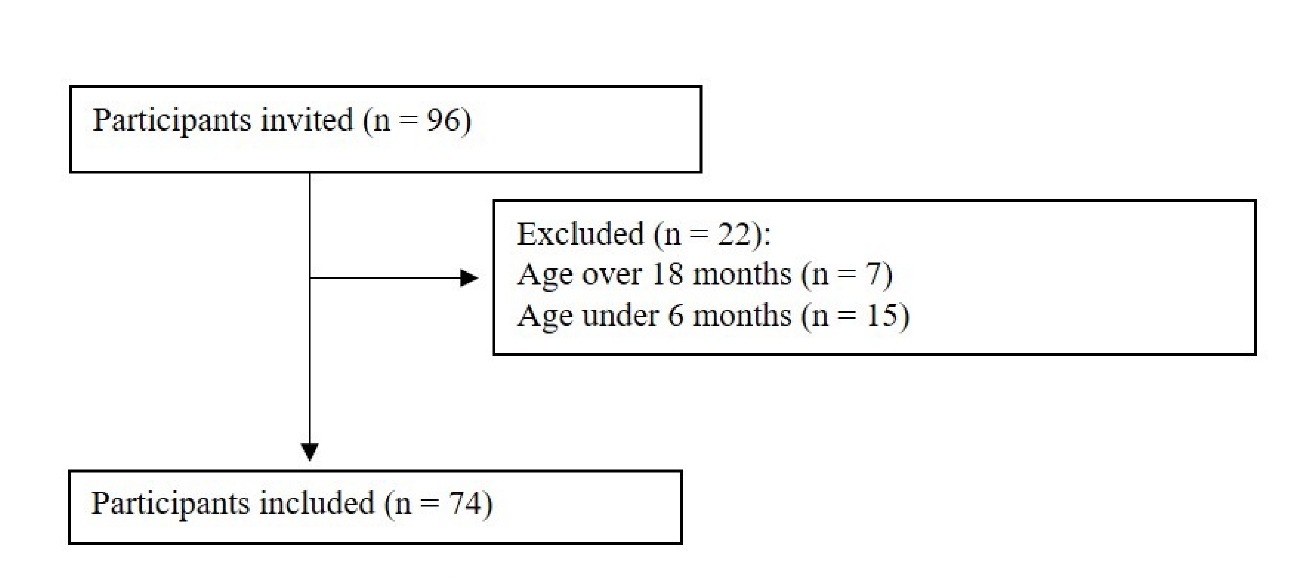
Figure 1 - Flow participants in the